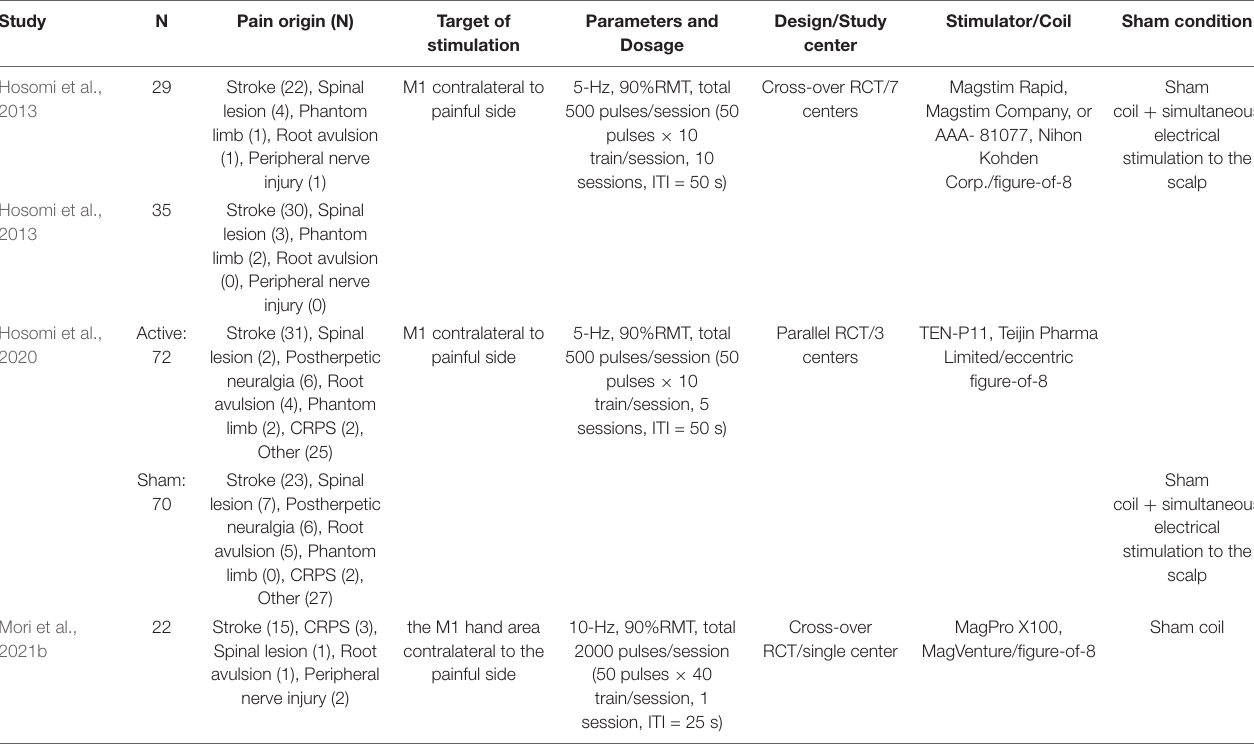
TABLE 1 | Characteristics of our previous rTMS studies using the figure-of-eight coil.